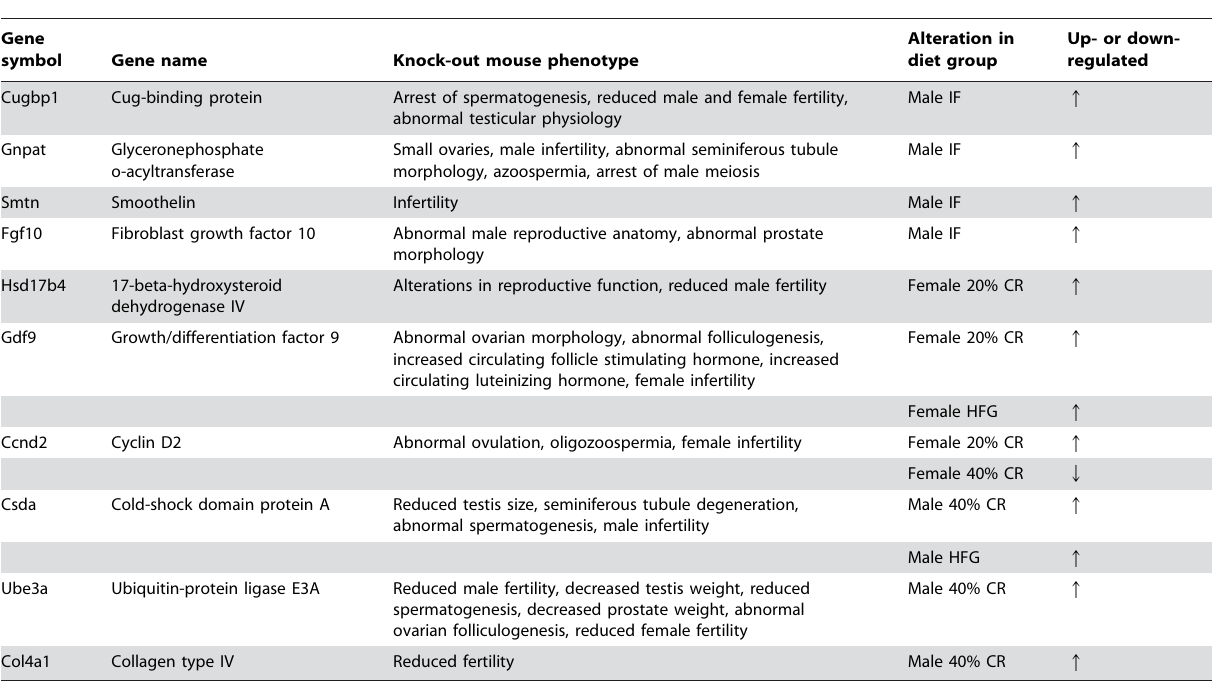
Table 3. Alterations in fertility-related genes in the male and female rats on the different dietary regimes.